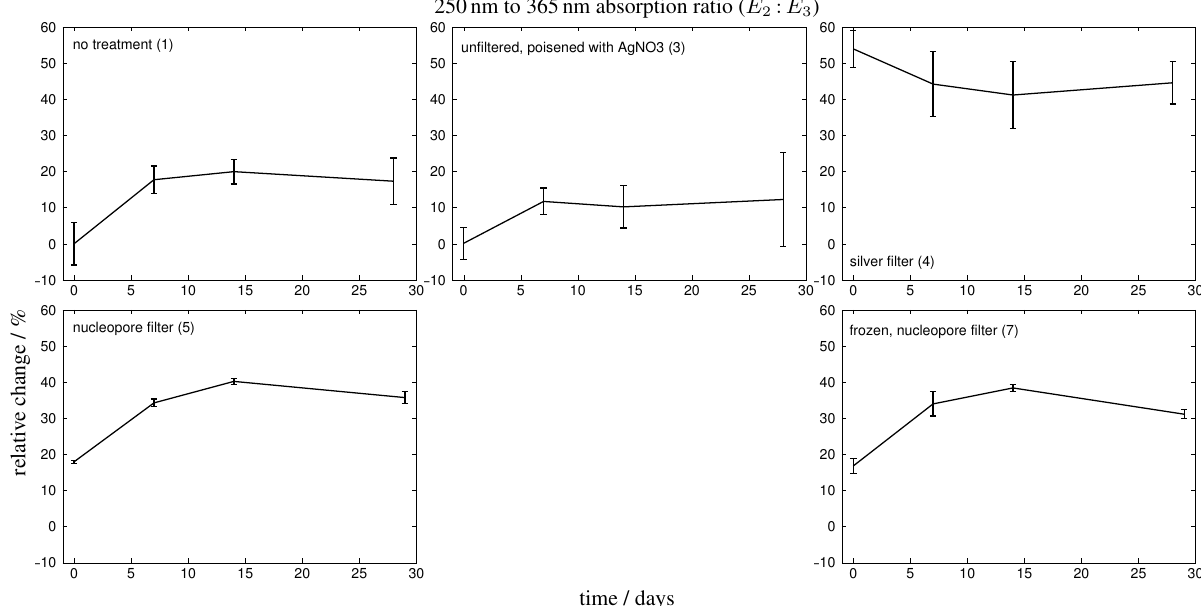
Fig. 4. Relative change of 250nm to 365nm absorption ratio ( E 2 : E 3 ) in respect to no treatments at t 0 vs. storage time for SML samples collected from the Tyne estuary for different treatments as detailed in Tab. 1. Differences at t 0 are caused by treatment effects. Treatments are labelled in each figure. Note that HgCl 2 is off scale and thus not shown.